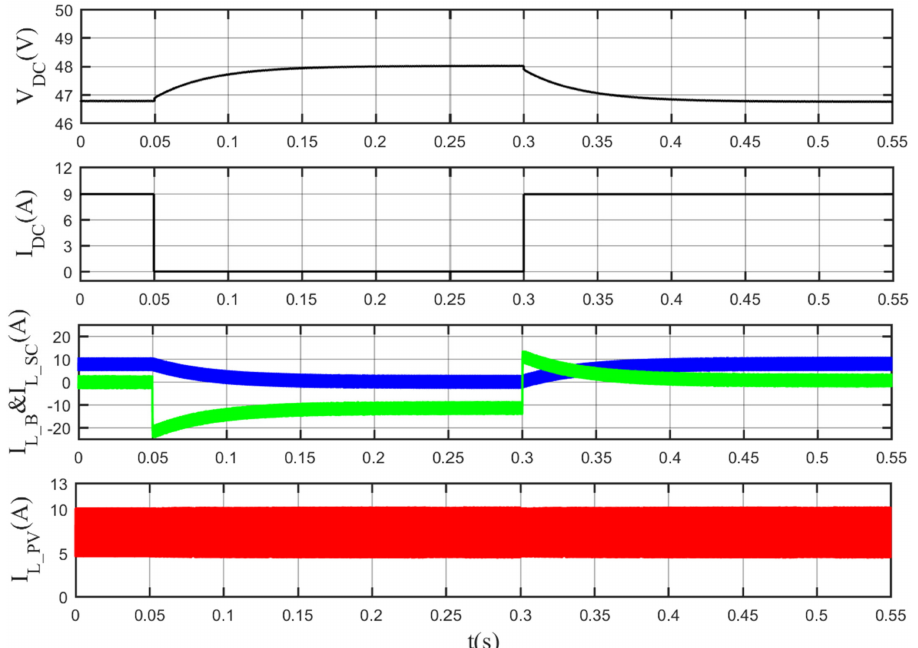
Figure 10. Simulation for dual droop scheme at supercapacitor voltage V SC = 18 V when the load changed from 5.2 Ω to no-load and back to 5.2 Ω .